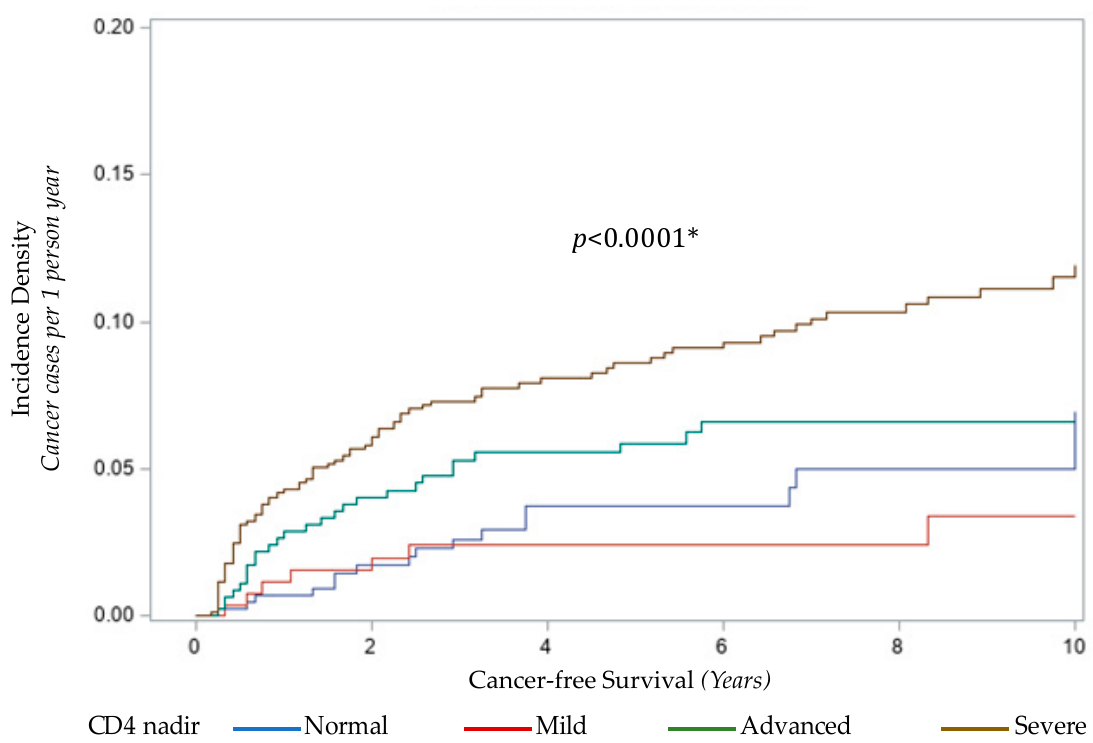
Figure 2. Incidence density function of cancer in children with HIV infection by CD4 Nadir during HIV care. *: p < 0.05